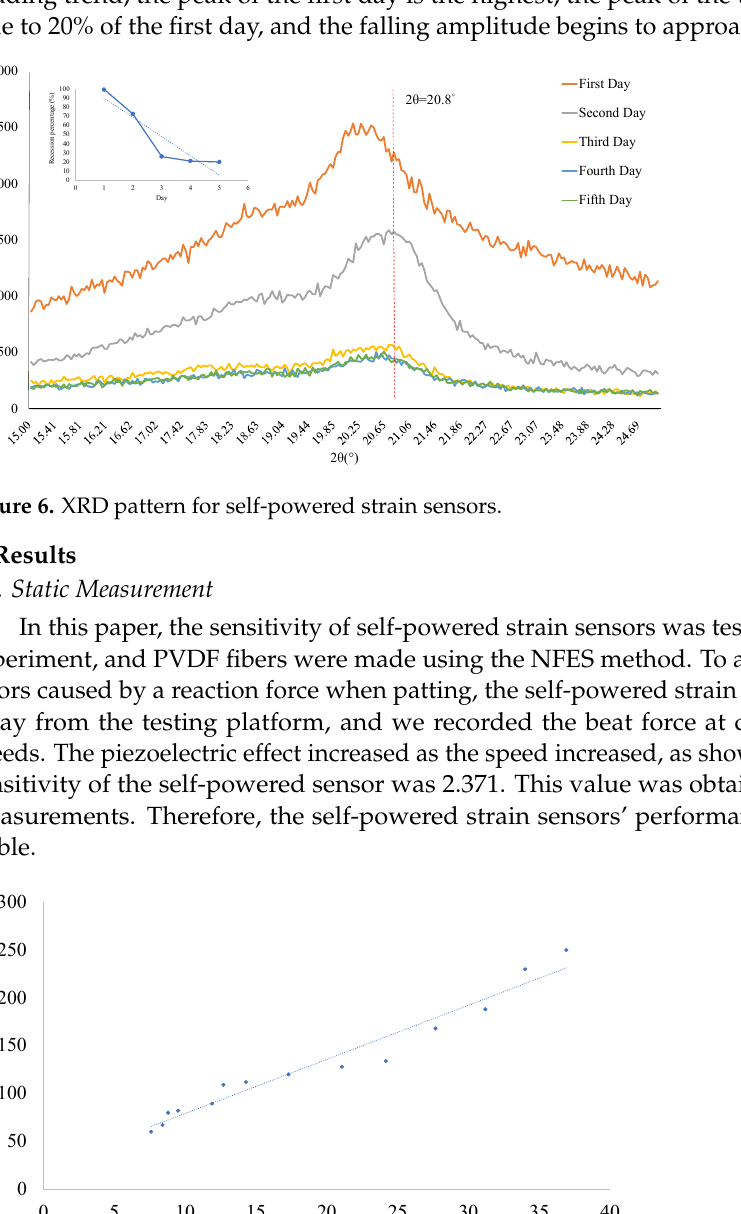
7 of 12 Figure 5. ( a ) PDMS and curing agent are formulated at a ratio of 10:1; ( b ) Thoroughly stir with a stirring bar; ( c ) Pour on the glass and wait for the bubbles to evaporate; ( d ) Put into an oven and perform closed heating in parallel. The temperature is 110 °C; ( e ) PVDF fiber film is laid out on PDMS film. Aluminum electrodes are attached to both ends of the PVDF fiber film; ( f ) Repeat steps ( a , b ), then pour the mixture over the element from ( e ); ( g ) Put into an oven and perform closed heating in parallel. The temperature is 40 °C; ( h ) Actual diagram of self-powered strain sensor.